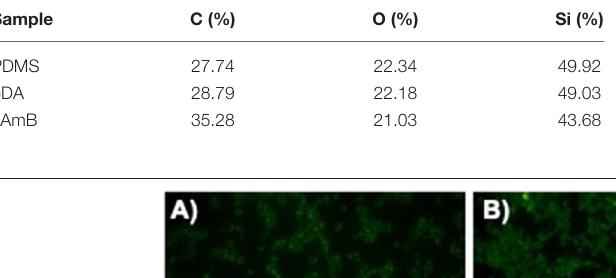
TABLE 2 | EDS quantification of atomic compositions on the polydimethylsiloxane surface (PDMS), pDA-coated PDMS (pDA), and pDA-coated PDMS surfaces functionalized with LAmB (LAmB).